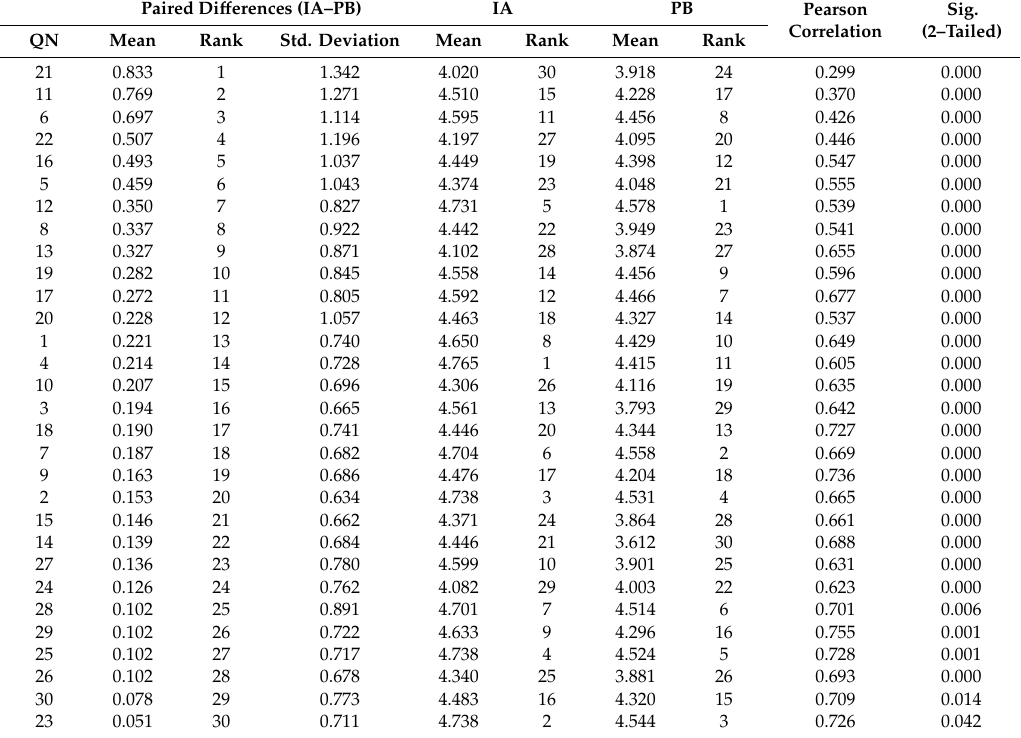
Table 5. Rank, means of importance and performance and paired samples ( n =